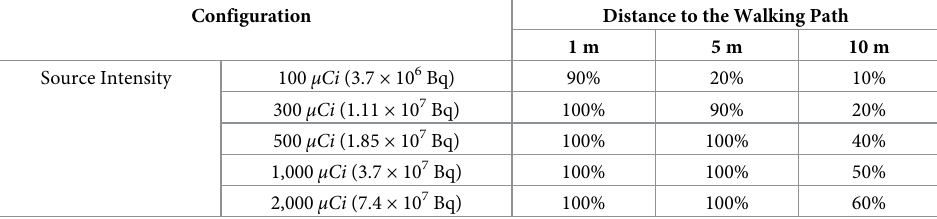
Table 4. Source identification accuracy with 10 meters distance threshold.